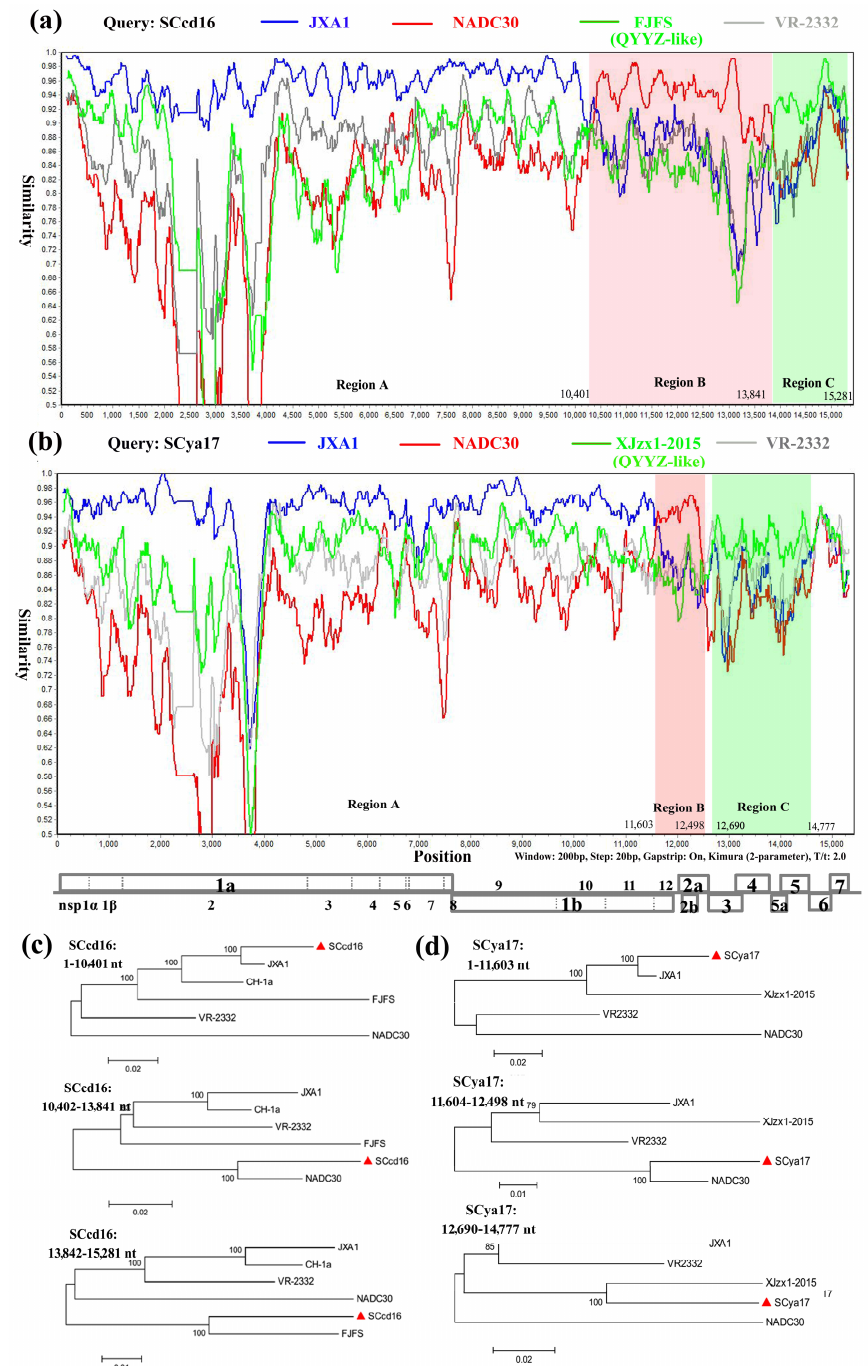
Figure 5. Recombination analysis of strain SCcd16 and SCya17. Analysis is made use of a sliding 2 window of 200-bp window and a 20-bp step. The y -axis indicates the percentage similarity between the query sequence and the reference sequences. ( a ) Genome scale similarity comparisons of SCcd16 (query) with JXA1 (blue), NADC30 (red), FJFS (QYYZ-like, green) and VR-2332 (gray); ( b ) genome scale similarity comparisons of SCya17 (query) with JXA1 (blue), NADC30 (red), XJzx1-2015 (QYYZ-like, green) and VR-2332 (gray). The supposed recombination regions are shown with different colors, and the recombination breakpoints are marked at the bottom with nucleotide sites and viral genome structure referenced to VR-2332; ( c ) phylogenetic trees based on different regions of SCcd16; ( d ) phylogenetic trees based on different regions of